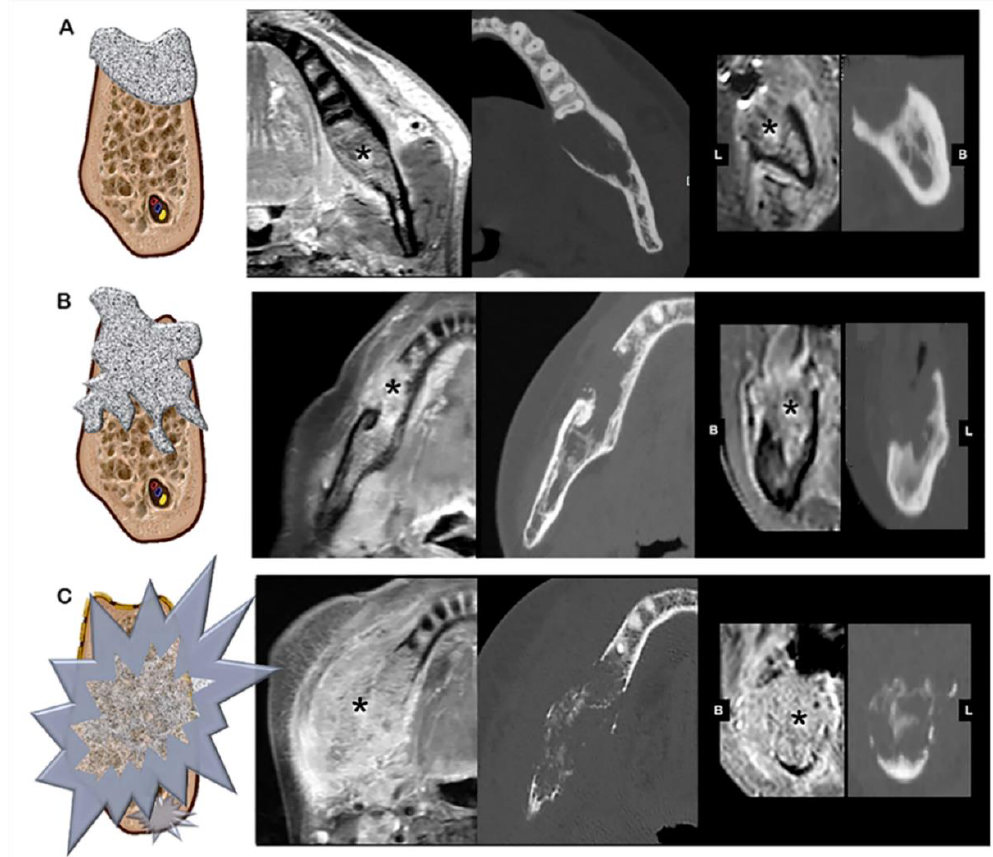
Figure 1. Imaging type classification. ( A ) Type I, smooth and round, with perilesional bone resorption, ( B ) Type II, rough and irregular bone margin around the lesion, and ( C ) Type III, extensive and unpredictable infiltration of the lesion into the buccal or / and lingual cortical bone. Panels on the right indicate a tumor mass on magnetic resonance imaging (MRI) and computed tomography (CT). Image sequences are, from left to right, contrast-enhanced T1-weighted MRI axial view, CT axial view, contrast-enhanced T1-weighted MRI coronal view, and CT coronal